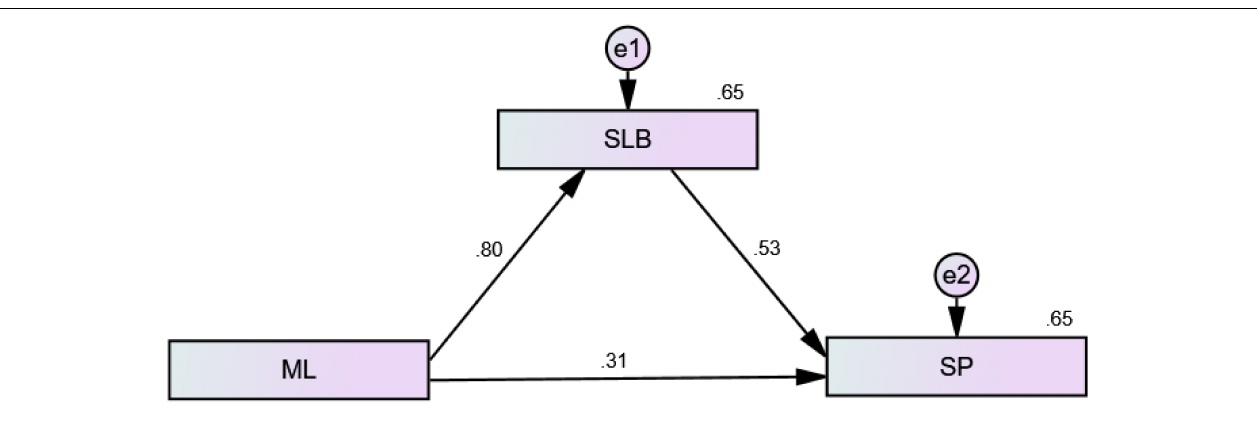
FIGURE 7 | Mediation analysis.